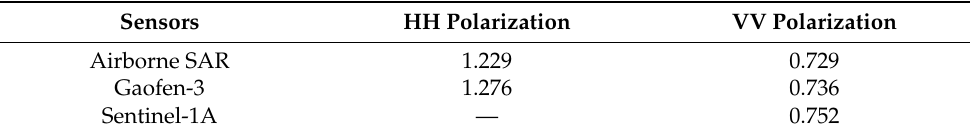
Figure 12. Comparison of normalized backscatter coefficients in the building area obtained with different sensors. Table 11. Statistical results for the backscatter coefficients in the building area obtained with different